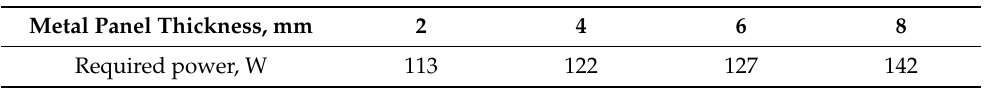
Table 3. Change in the power of the heating system when the thickness of the panel under repair is